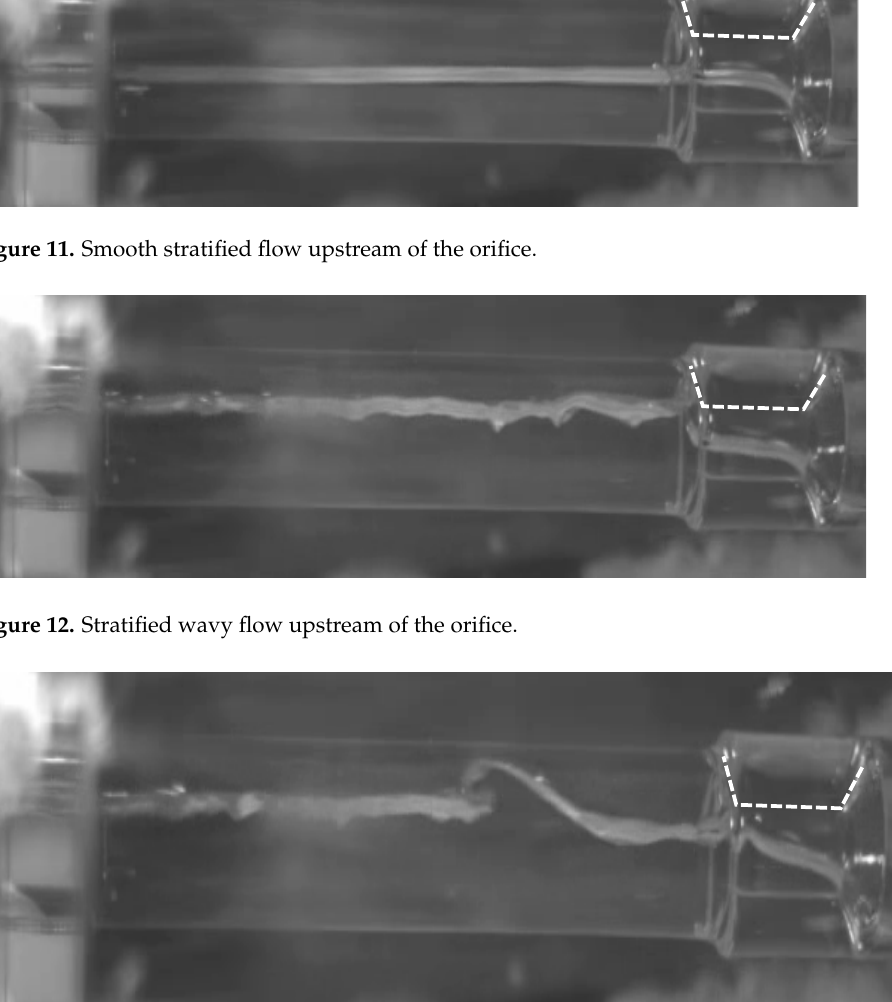
Figure 13. Sudden rise of a wave upstream of the orifice.